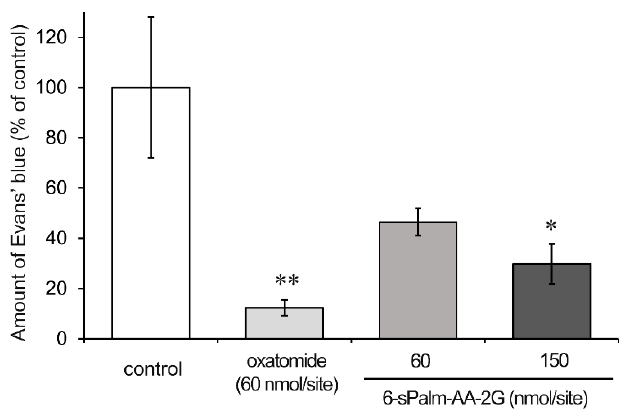
Figure 7. Inhibitory effect of 6-sPalm-AA-2G on PCA reaction in mice. Mice were percutaneously administered the indicated samples: control ( n = 7), oxatomide ( n = 5), 6-sPalm-AA-2G 60 nmol/site ( n = 4), 150 nmol/site ( n = 5). All data represent means ± SE. * p < 0.05, ** p < 0.01 (Dunnett’s test) as compared with the control.